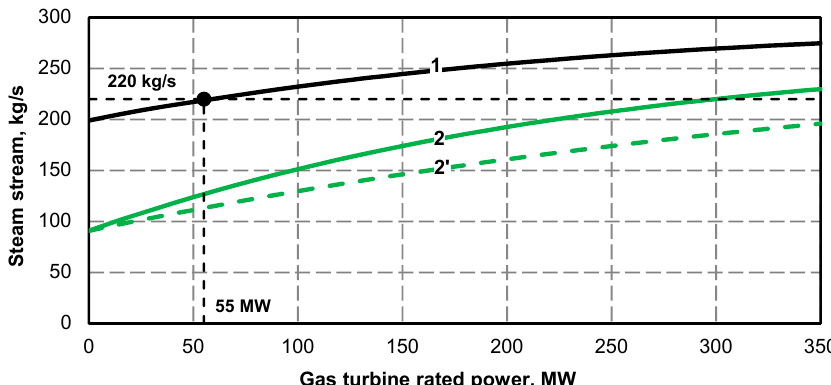
Figure 38. The stream of outlet steam from the low-pressure steam turbine part to the KQ1 condenser as a function of gas turbine rated power: 1 — maximum fixed stream of 319.4 kg/s fresh steam fed to steam turbine; 2 — minimum steam boiler output of 133.3 kg/s and gas turbine operating at a rated power, 2’ — minimum steam boiler output of 133.3 kg/s and gas turbine operating with 60% of its rated power.